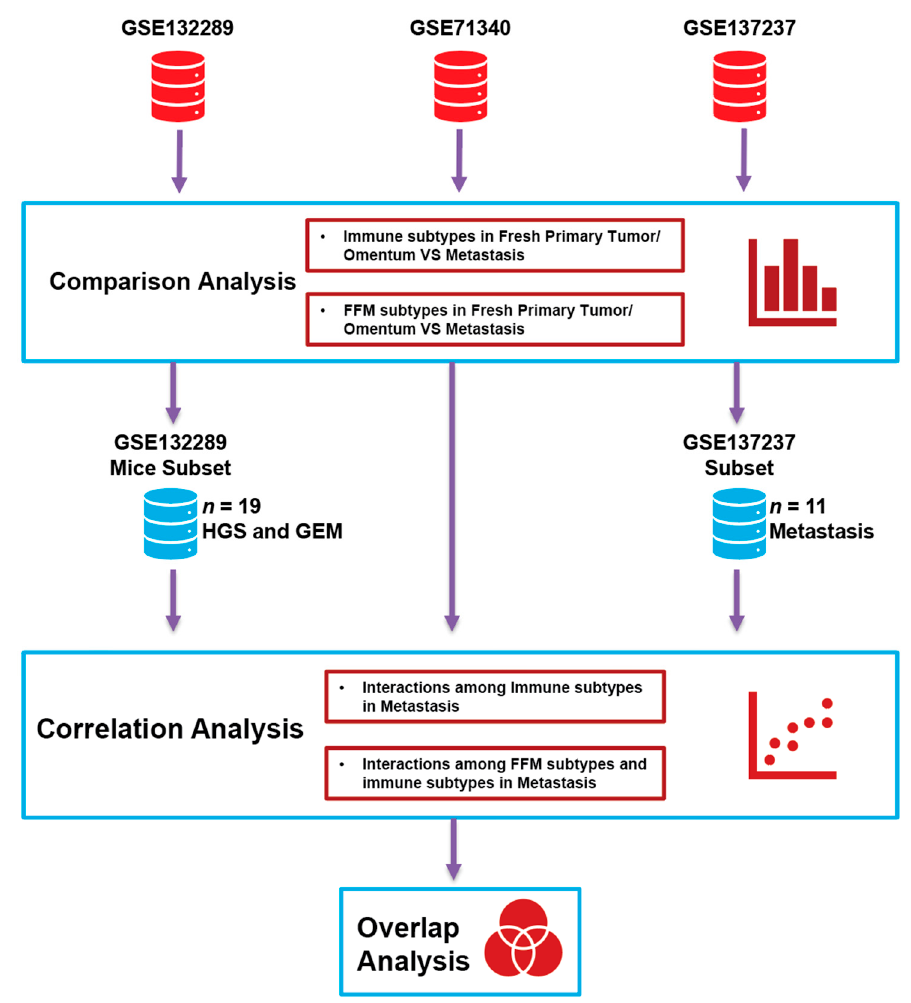
Figure 1. Analysis workflow: Three ovarian cancer (OC) RNA-seq datasets comparing normal omentum and omental metastasis (dataset GSE132289), omental metastasis (GSE71340) and matched primary tumors and metastasis (GSE137237) were analyzed. Only the normal omentum and omental metastasis from mice were included in the analysis from GSE132289. They were first analyzed for immune cell subtypes and fibroblast subtypes using a deconvolution algorithm developed in-house. Thereafter, correlations between the immune subtypes and fibroblast subtypes were determined to identify the role of specific microenvironmental fibroblasts in modulating the tumor-immune microenvironment. Finally, the immune-relevant genes common to the di ff erent datasets were identified. HGS: high-grade serous ovarian cancer syngeneic mouse models, GEM: genetically engineered mouse, FFM: fibroblast functional